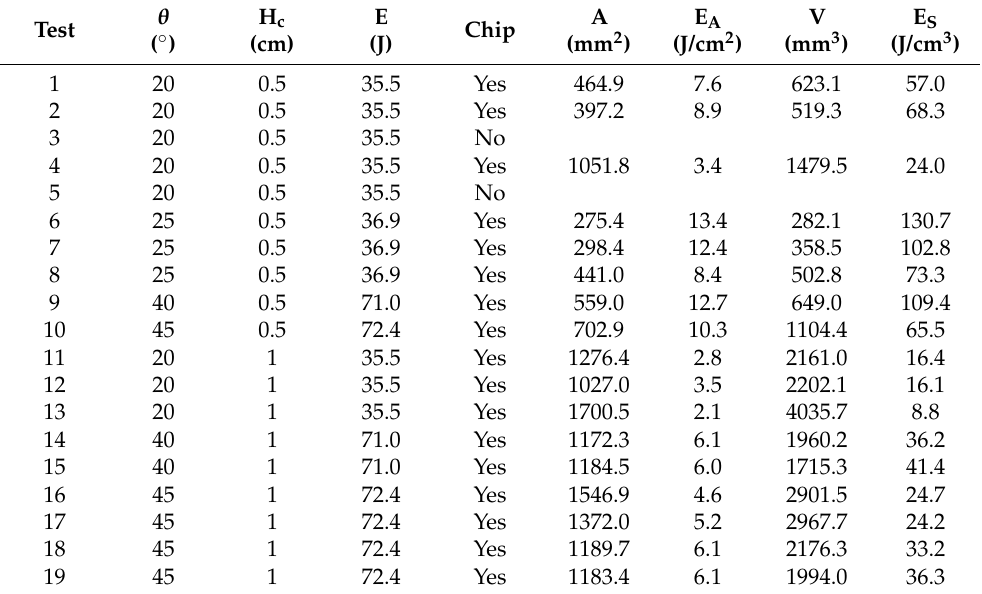
Table 3. Summary of tests on samples with a c/s ratio of 3:1. (The precision of the measures is of the order of 0.5 ° for θ and 0.1 cm for H C . Besides, the precision of the scanner 3D is 5 mm).